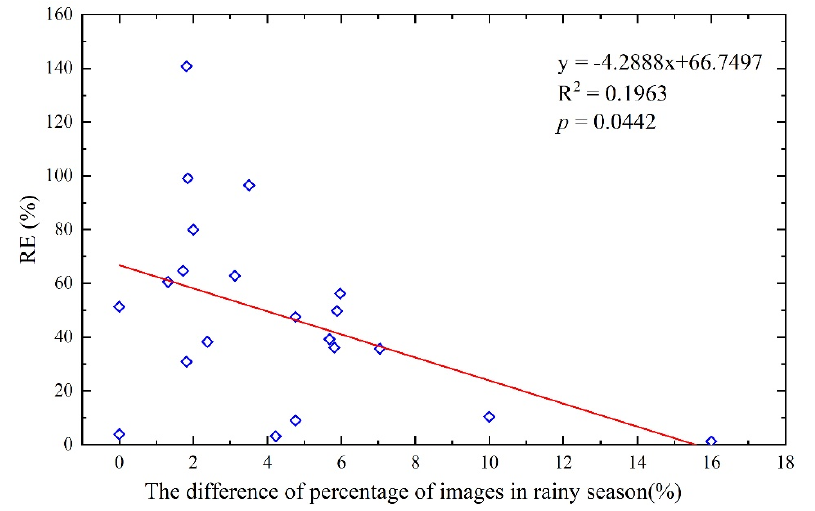
Figure 9. The relationship between the difference in the percentage of images in the rainy season and the relative error (RE) in the annual average area of algal blooms between Landsat and MODIS/Terra.